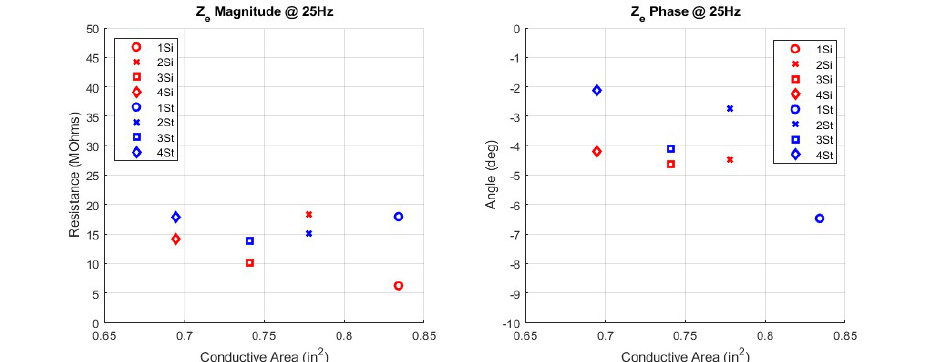
Figure 10. Pattern and Yarn type Comparison versus Impedance Z e ; Patch Surface Area = 5.74 cm 2 , Magnitude ( left ), Phase ( right ).